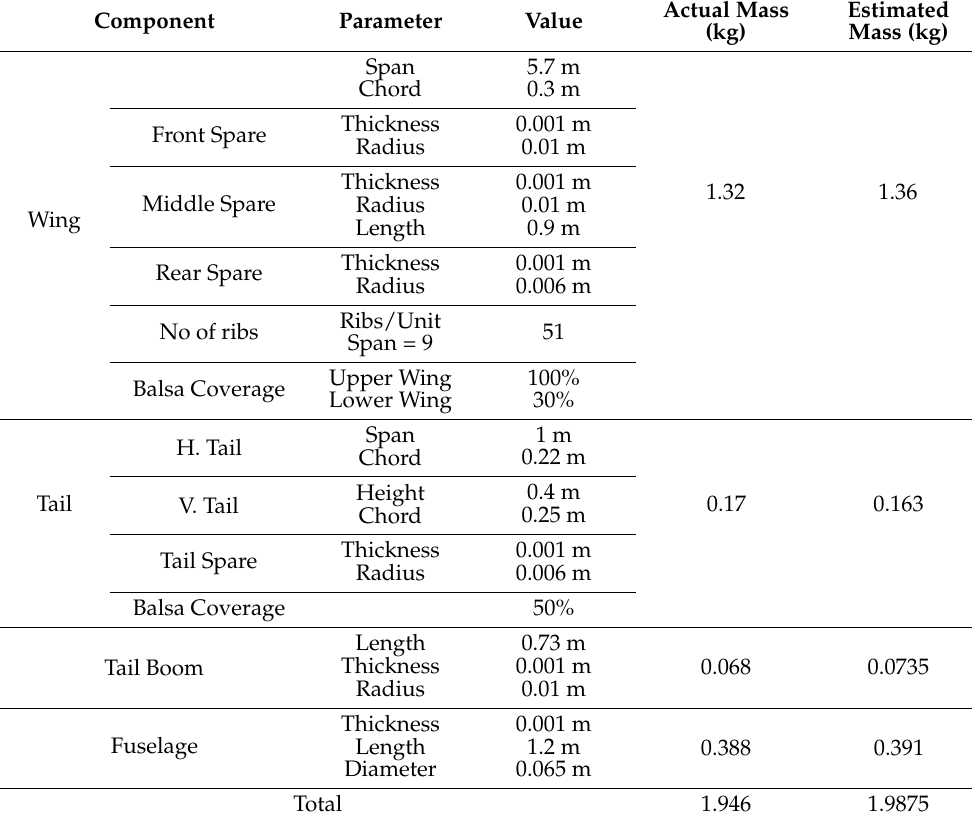
Table 3. Comparison of calculated and actual structural mass.